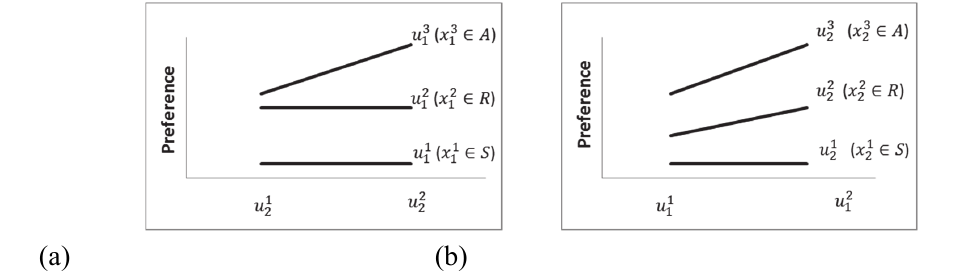
Fig. 7. Preference structure for the illustrative example. (a) Effect of surface roughness for different values of thickness. (b) Effect of thickness for different values of surface